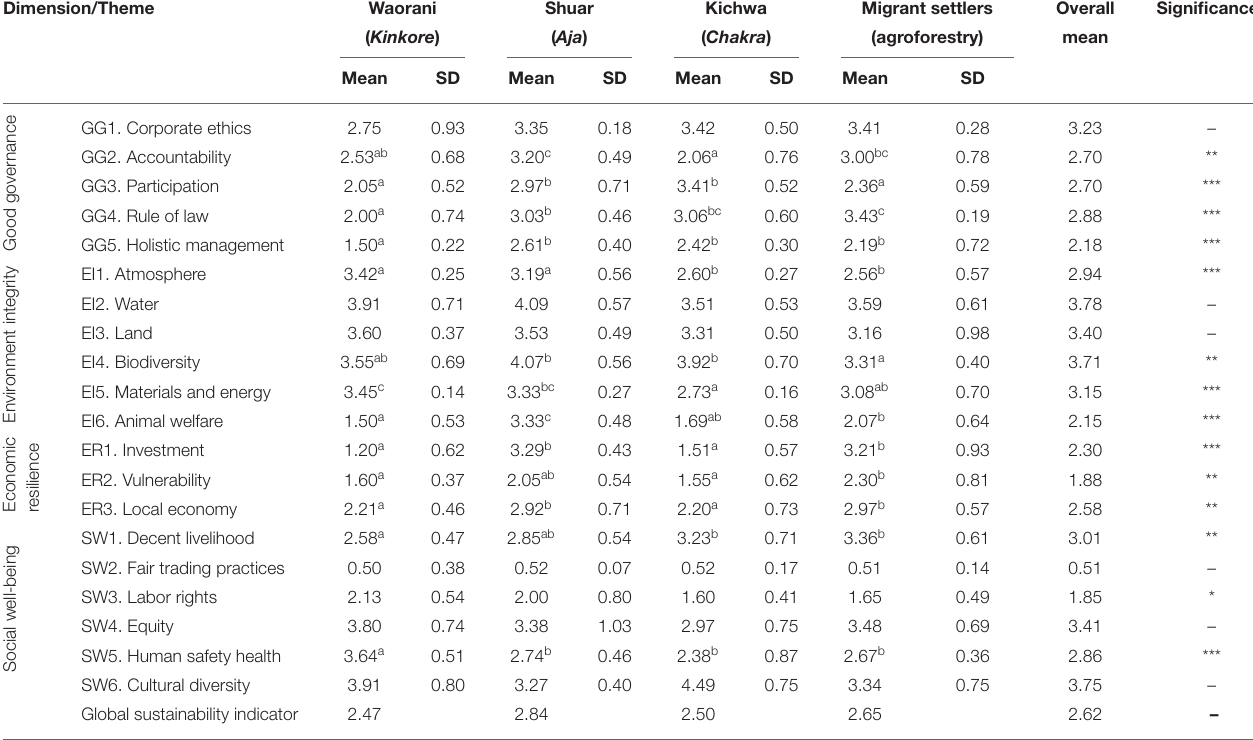
TABLE 7 | Means and standard deviations of the themes of the sustainability evaluation in four production systems (Waorani, Shuar, Kichwa, and migrant settlers) in the Yasuní Biosphere Reserve, Amazon region of Ecuador. Dimension/Theme Waorani Shuar